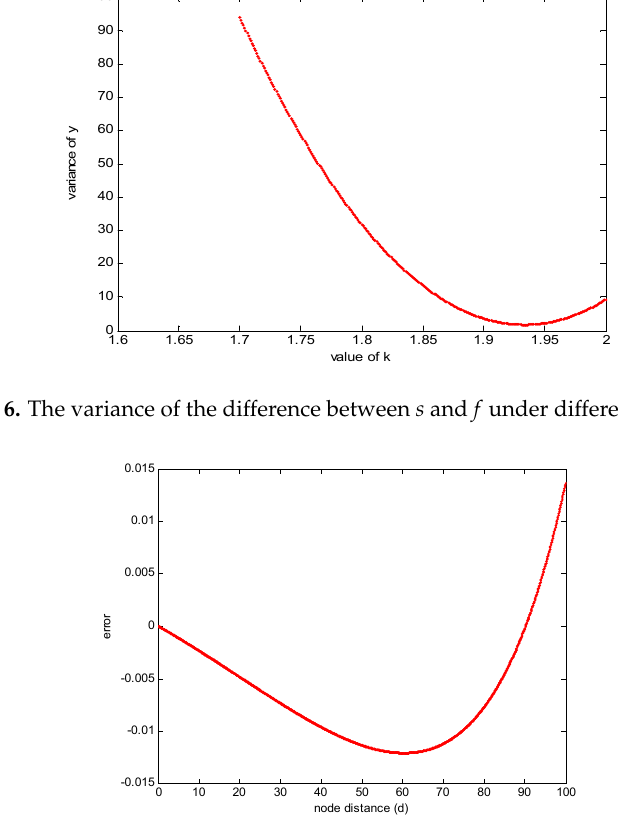
Figure 7. The evaluation error between s and f.